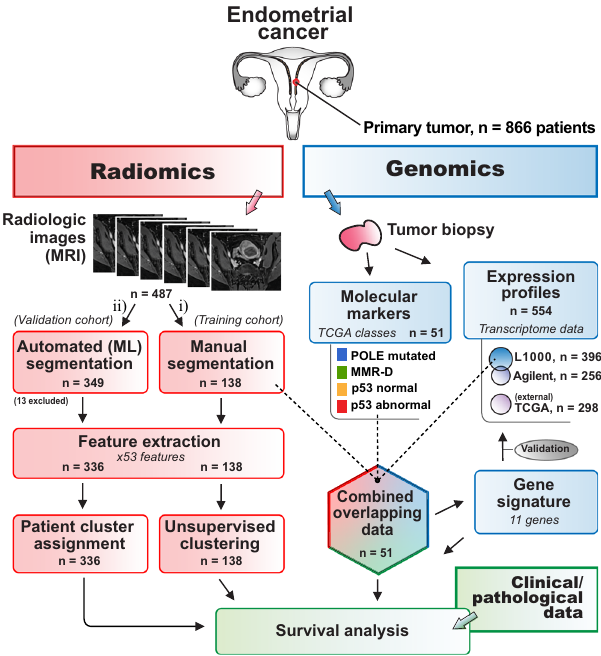
Fig. 1 Radiogenomics approach in the current study of 866 endometrial cancer patients. Overview of the analytical approach integrating radiomics (red), genomics (blue), and clinical/pathological data (green). Preoperative MRI from 487 endometrial cancer patients were used for primary tumor segmentation using two approaches; (i) manual segmentation by radiologists (training cohort, 138 patients) and (ii) automated segmentation (using machine learning [ML] validation cohort, 349 patients, of which 13 patients were excluded due to failed automated tumor